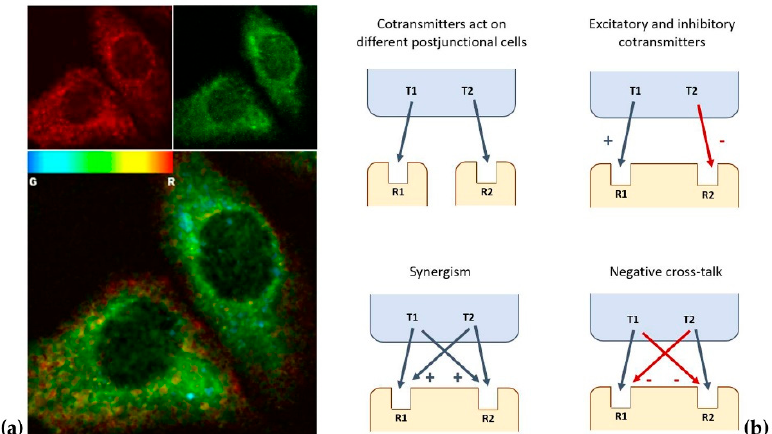
Figure 2. ( a ) Immunofluorescence images of cholecystokinin (red fluorescence) and dopamine (green fluorescence) in cultured nerve cells. In the lower panel, the corresponding map of green/red ratios is shown, from which the degree of co ‐ localization can be evaluated by computer ‐ assisted image analysis protocols (see [105] for details). ( b ) Examples of signaling variations offered by co ‐ transmission (see [110] for details).